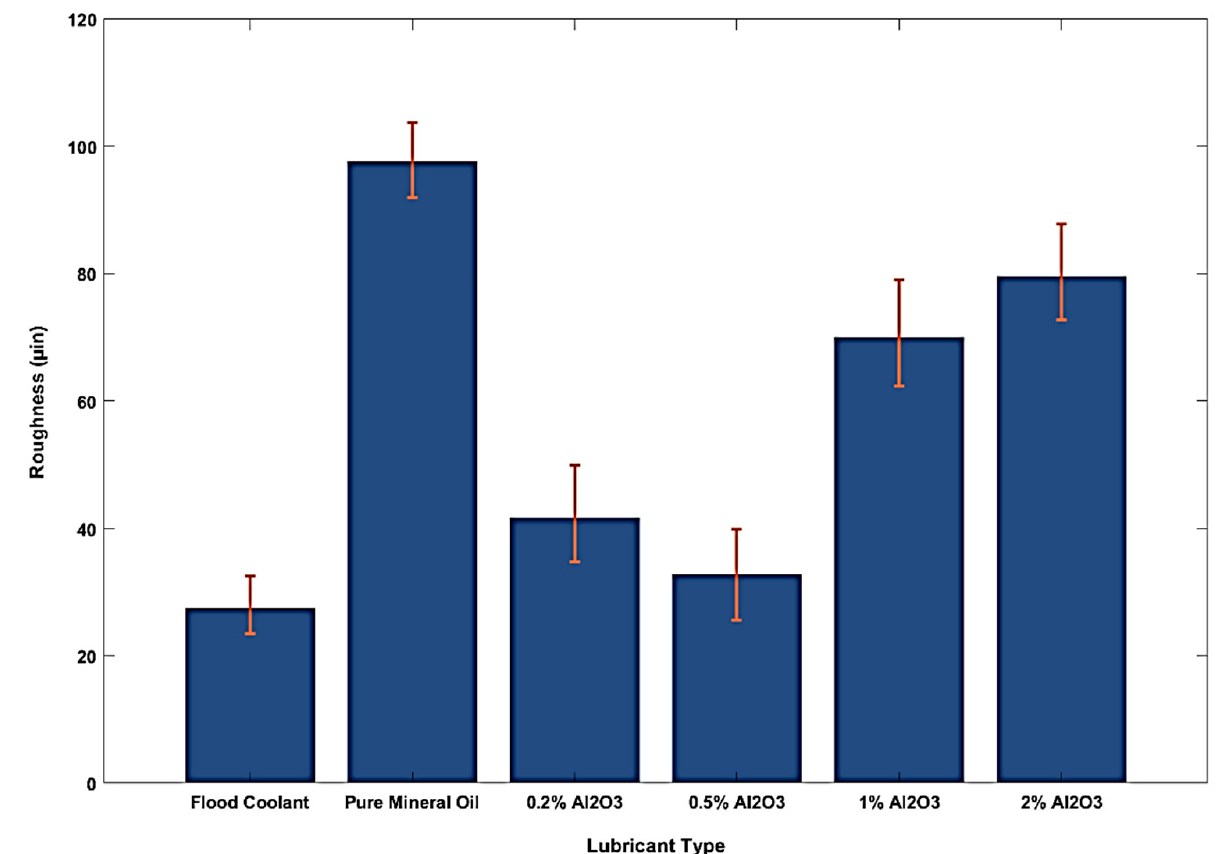
Figure 2. Surface roughness (R a value) obtained using different lubricant types.